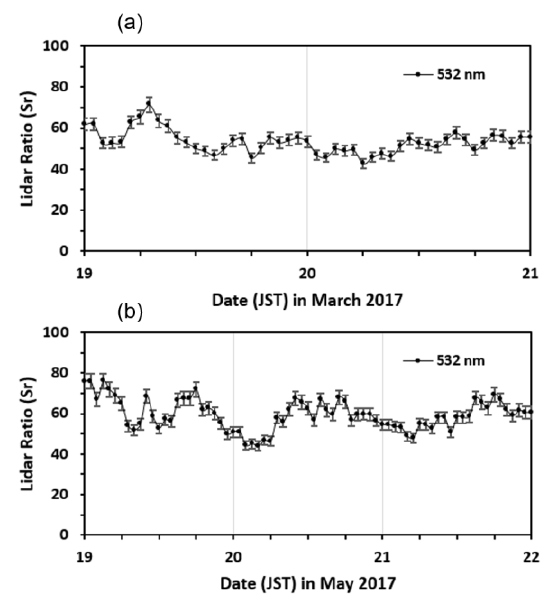
Fig. 3 Temporal change of lidar ratio in the case of (a) low RH observed during March 19-20, 2017 and (b) high RH observed during May 19-21,